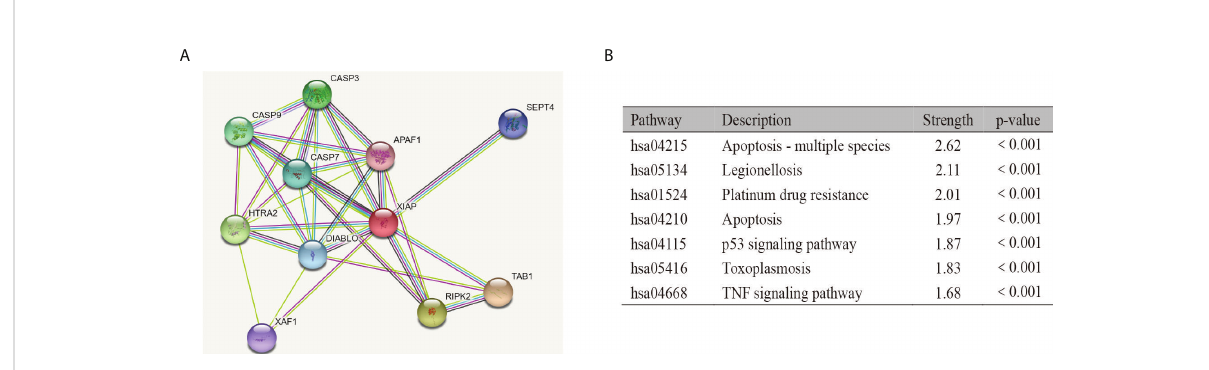
FIGURE 4 Function analysis of XIAP. The protein-protein interaction (A) and KEGG pathway analysis (B) of XIAP.